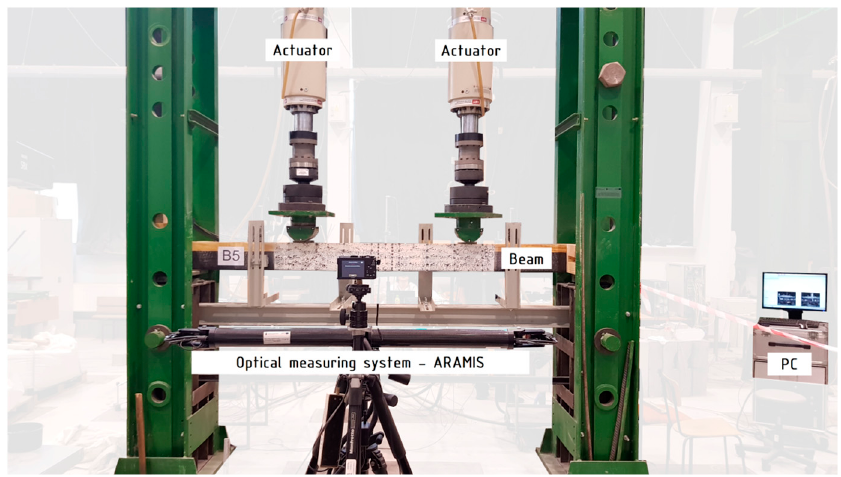
Figure 9. View of the static test setup.